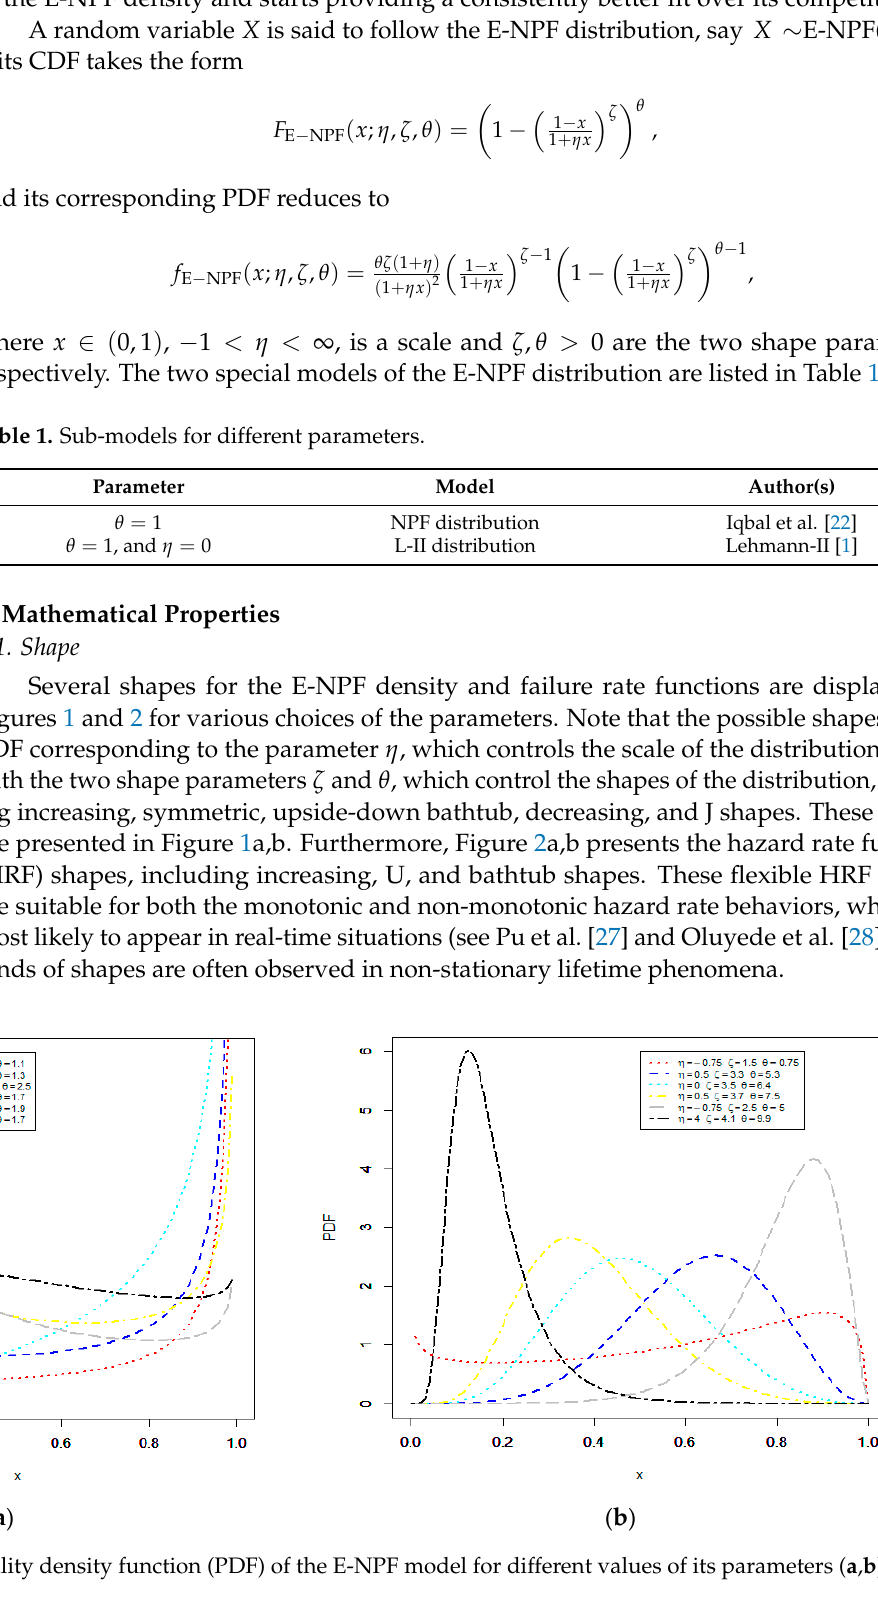
( a ) ( b ) Figure 2. Plots of the hazard rate function (HRF) of the E-NPF model for different values of its parameters ( a , b ). 3.2. Linear Representation Linear combination provides a simple way to explore the mathematical properties of the model. For this reason, binomial expansion is utilized. It is given as (1 − 𝑧) (cid:3109)(cid:2879)(cid:2869) = (cid:3533)(−1) (cid:3037) (cid:3436)𝜙 − 1 𝑗